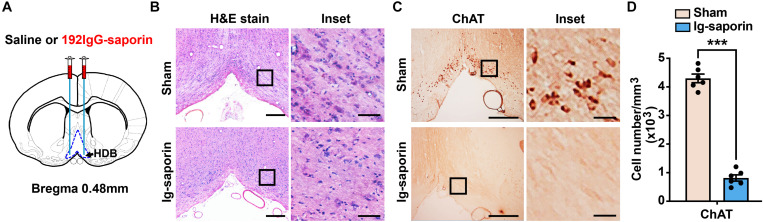
Infusion of 192 IgG-saporin into the HDB substantially reduced the number of cholinergic neurons. (A) Location of cannula placements in the HDB. (B) H&E stain showed the cell loss in the HDB. (C) ChAT immunostainings in the HDB showed a near complete loss of cholinergic neurons. (D) Quantitative analysis revealed significant differences in the number of ChAT-positive cell density between the two groups (n = 6 per group). Data are represented as mean ± SEM; ***p < 0.001, compared to the sham group; two-tailed t-test. Scale bars: 300 μm; 50 μm (inset).